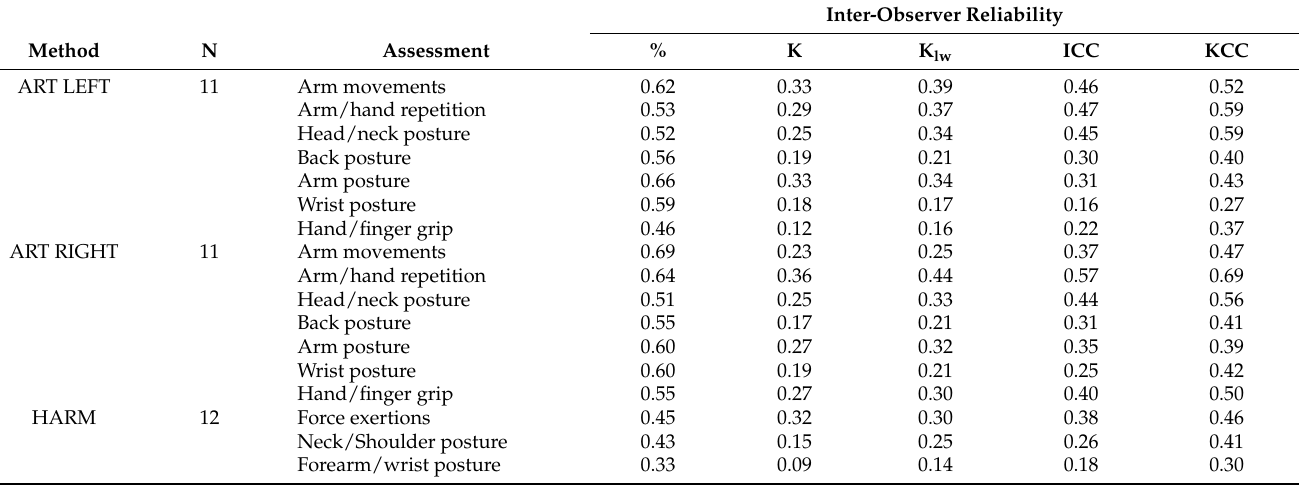
Table A3. The inter-observer reliability for the items (posture and movements/repetition) in each method that were rated by the ergonomists (in the first session) from the video-recorded work tasks. Number of ergonomists (n), proportional agreement (%), Cohen’s kappa (K), linearly weighted kappa averaged over pairs (K lw ), intraclass correlation (ICC) and Kendall’s coefficient of concordance